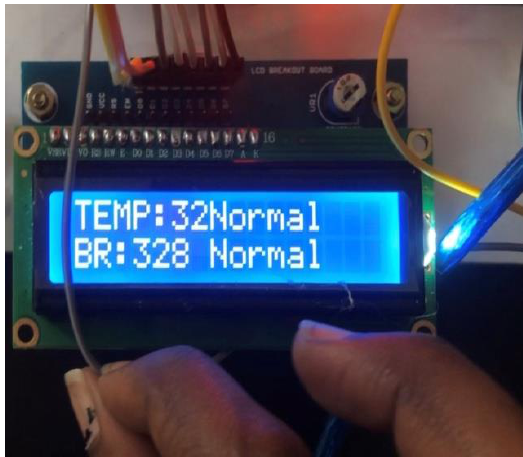
Fig 7: LCD display when the condition is normalised after therapy